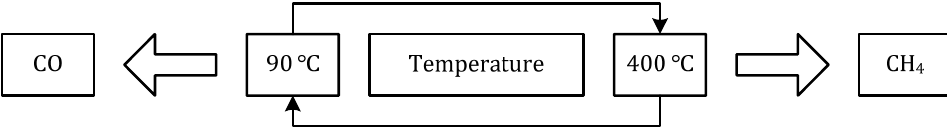
Figure 2. A thermostatic cycle of a sensitive element for CO and CH